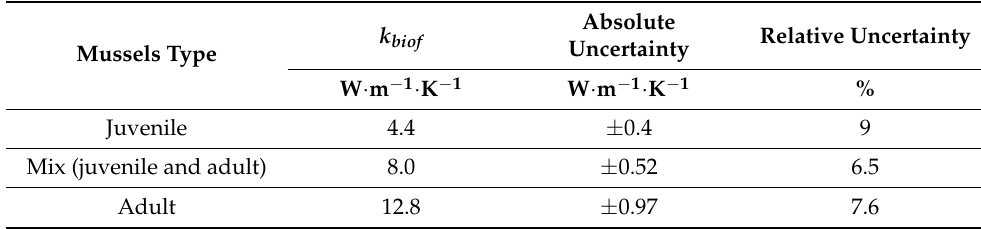
Table 2. Measured effective thermal conductivities of mussels of various ages uniformly distributed around the aluminum tube.